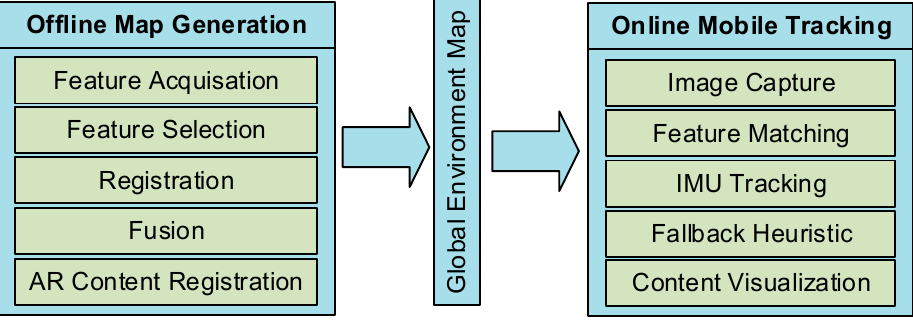
Figure 1. Developed packages for the HyMoTrack framework.